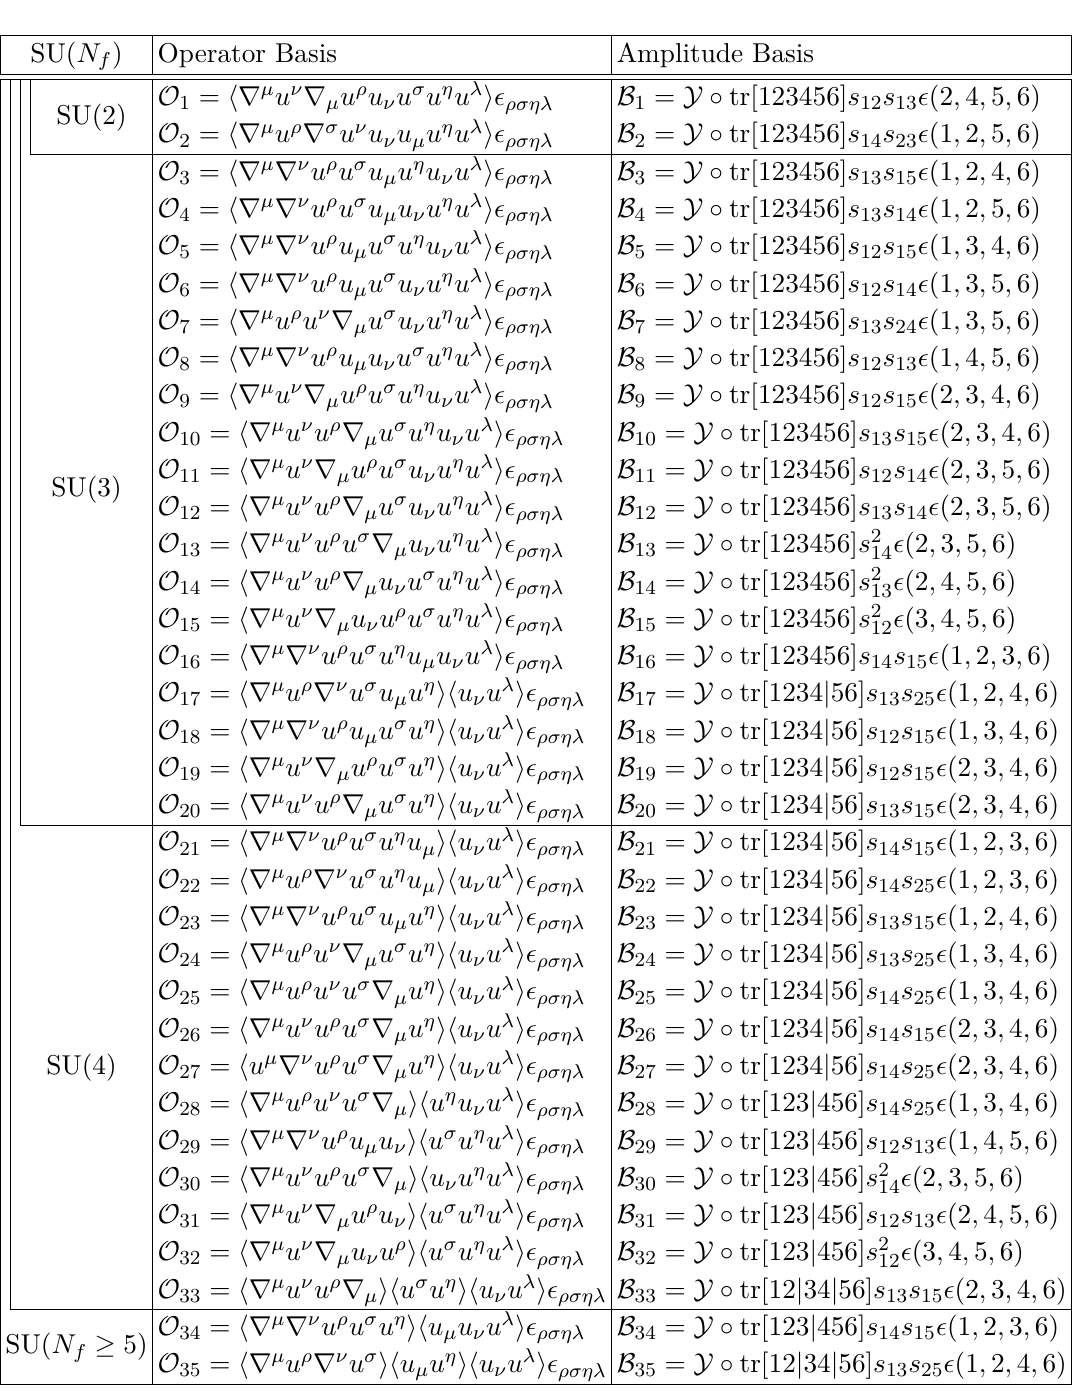
Table 14 . A complete set of 6-Goldstone parity-odd operators in p 8 order. The number of in- dependent monomials for SU(2) , SU(3) , SU(4) and SU( N respectively, agreeing with